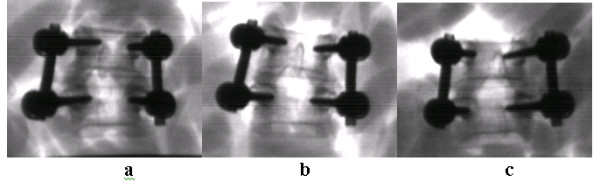
Digitised fluoroscopic images of calibration model 2 right rotated (a), neutral (b) and left rotated (c).